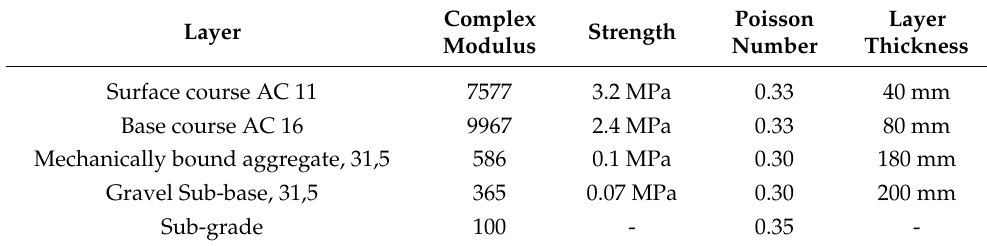
Table 2. Pavement construction